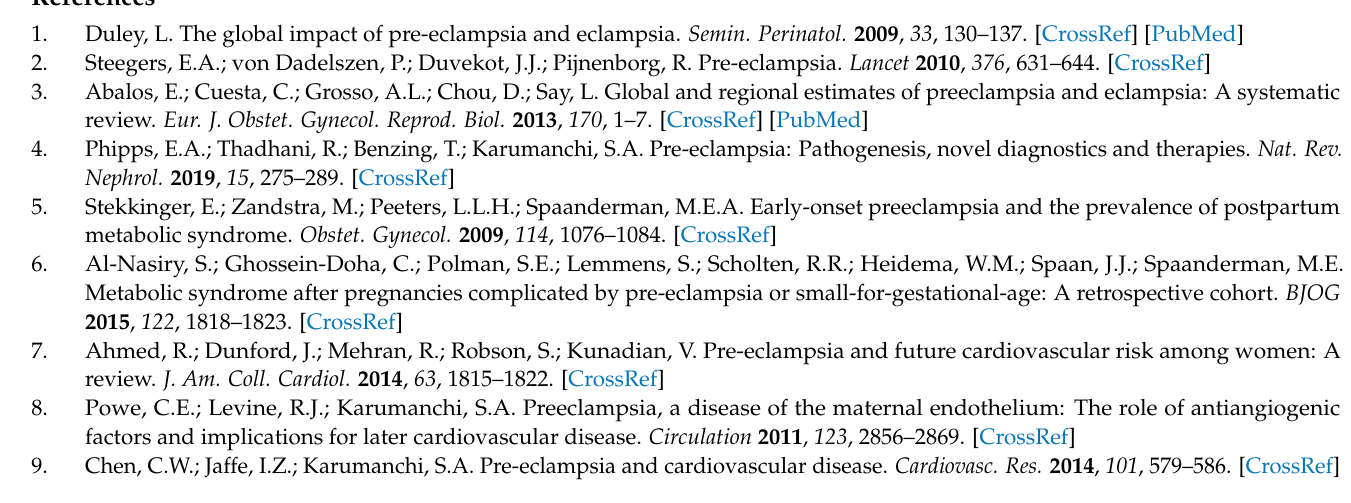
Table S2: The significantly enriched GO biological processes in the cyan and magenta PPI clusters and the processes’ associated proteins. Table S3: Cyan and magenta cluster genes overlapping with the HAR gene set and PS gene set. Table S4: The significantly enriched reactome pathways in the cyan and magenta PPI clusters and the pathways’ associated proteins. Table S5: The results of the Cytohubba analysis of the cyan and magenta PPI